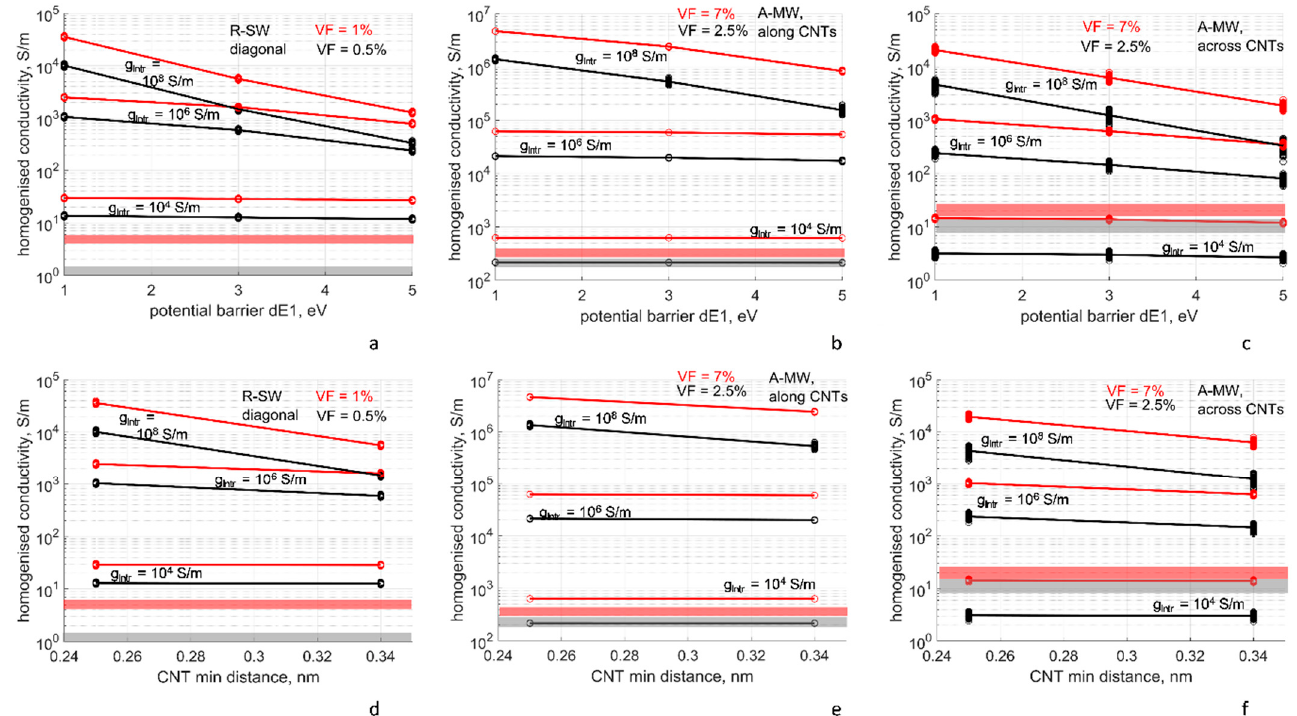
Figure 8. The homogenized conductivity as function ( a – c ) of the assumed potential barrier ∆ E 1 for the tunneling conductivity, with s min = 0.34 nm, and ( d – f ) of the minimal distance between CNTs, with Δ E 1 = 3 eV, at three levels of the CNT intrinsic conductivity g intr and two levels of the CNT volume fraction: ( a , d ) R-SW, diagonal components of the conductivity tensor; ( b , e ) A-MW, along CNTs; ( c ,f) A-MW, across CNTs. The points show conductivity values corresponding to different RVE random realizations (sampling size ≥ 99 for all cases); the lines show mean values. The horizontal boxes show the homogenized conductivity range measured for R-SW [65] and A-MW [69] experimentally. The colors of the lines, points, and boxes correspond to CNT volume fractions, as shown on the graphs.